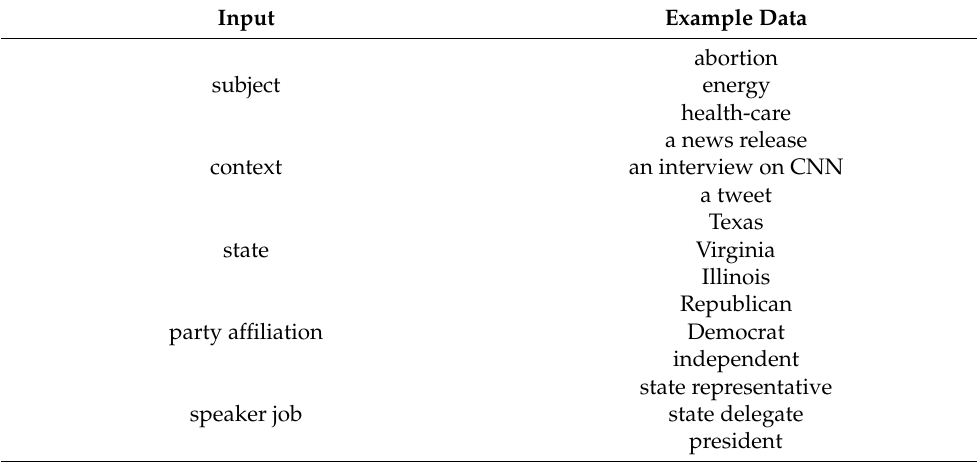
Table 2. Example Data (input names and example data from the Sentimental LIAR dataset